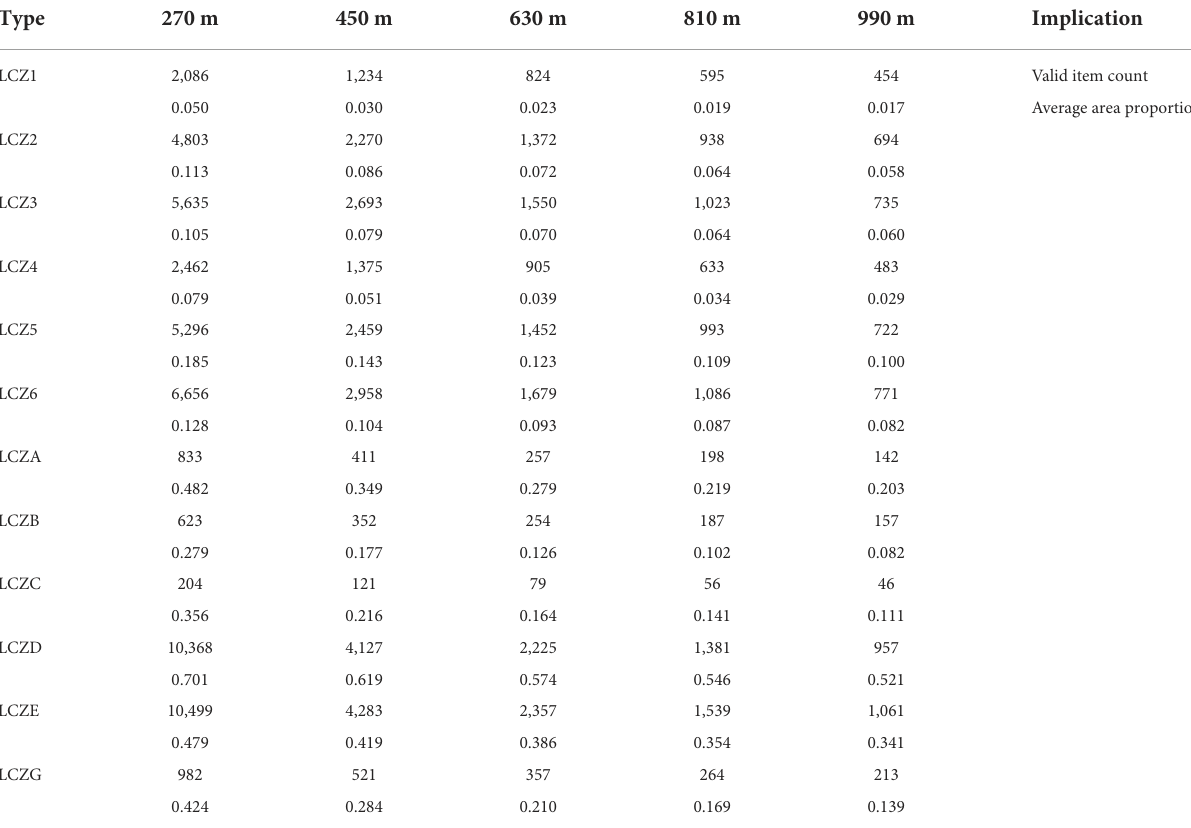
TABLE 3 The quantitative characteristics of the LCZ area proportion.